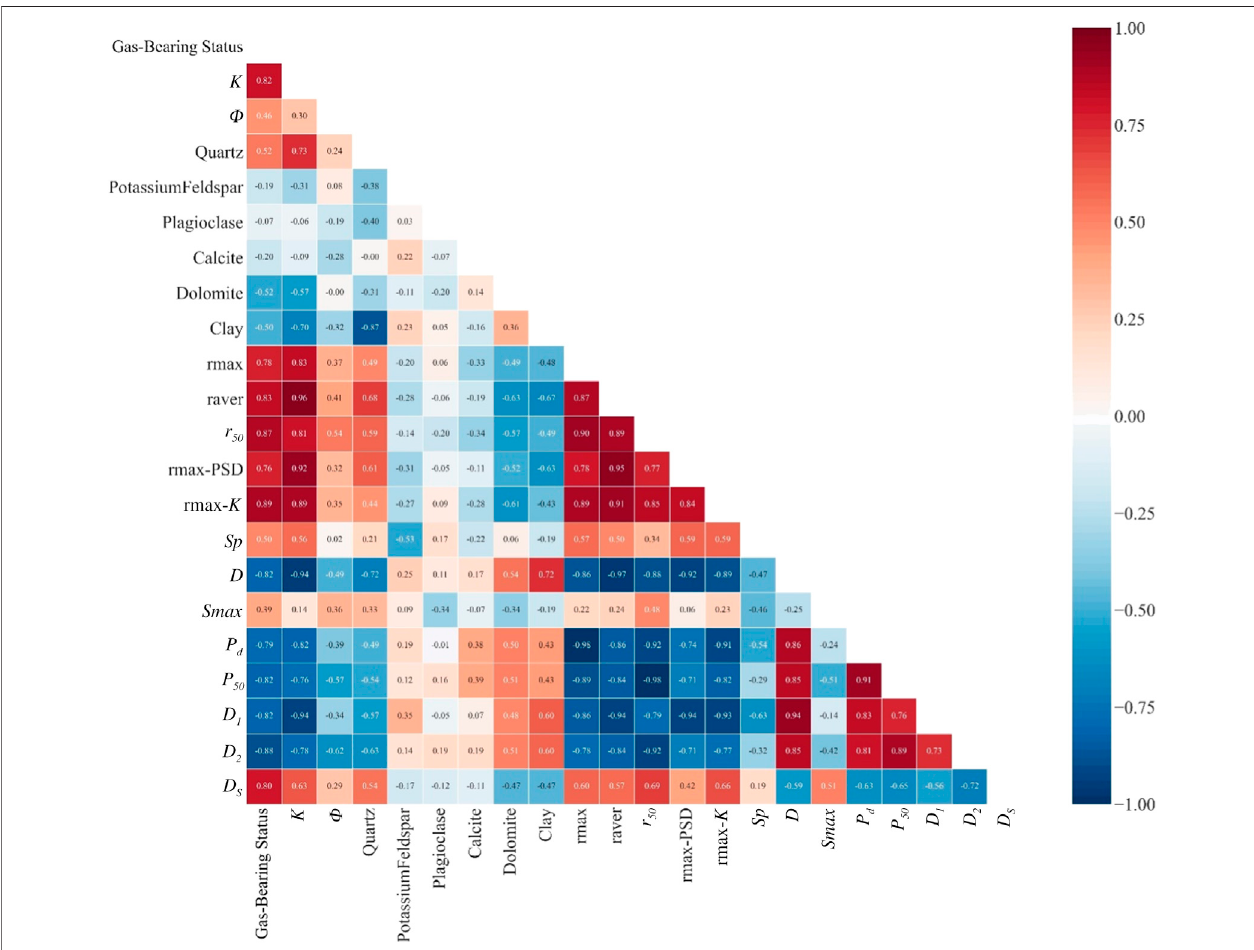
FIGURE 9 | Heatmap showing the correlation relationships among petrophysical parameters, mineral compositions, pore structure parameters , and gas-bearing status. *There are two values for “ Gas-bearing status ” : True or False, representing gas-bearing and dry formations. The color of the heatmap ranges from dark blue to dark red, representing a correlation coef fi cient of − 1 (negative correlation) to 1 (positive correlation), respectively.